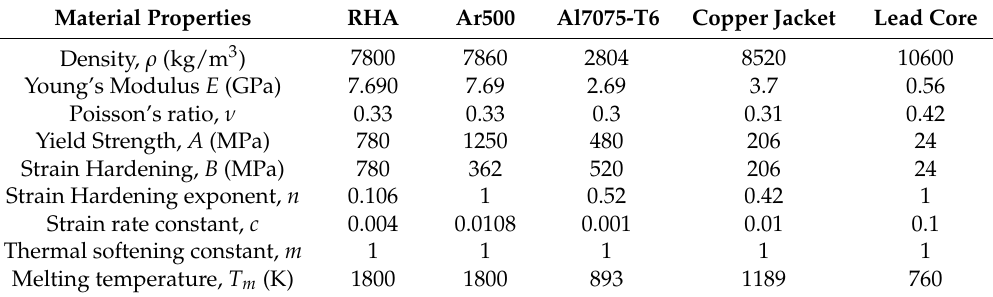
Table 1. Material properties and modified Johnson–Cook model parameters, adopted from [9,16] with permission from Springer Nature, 2010 and Elservier, 2009.